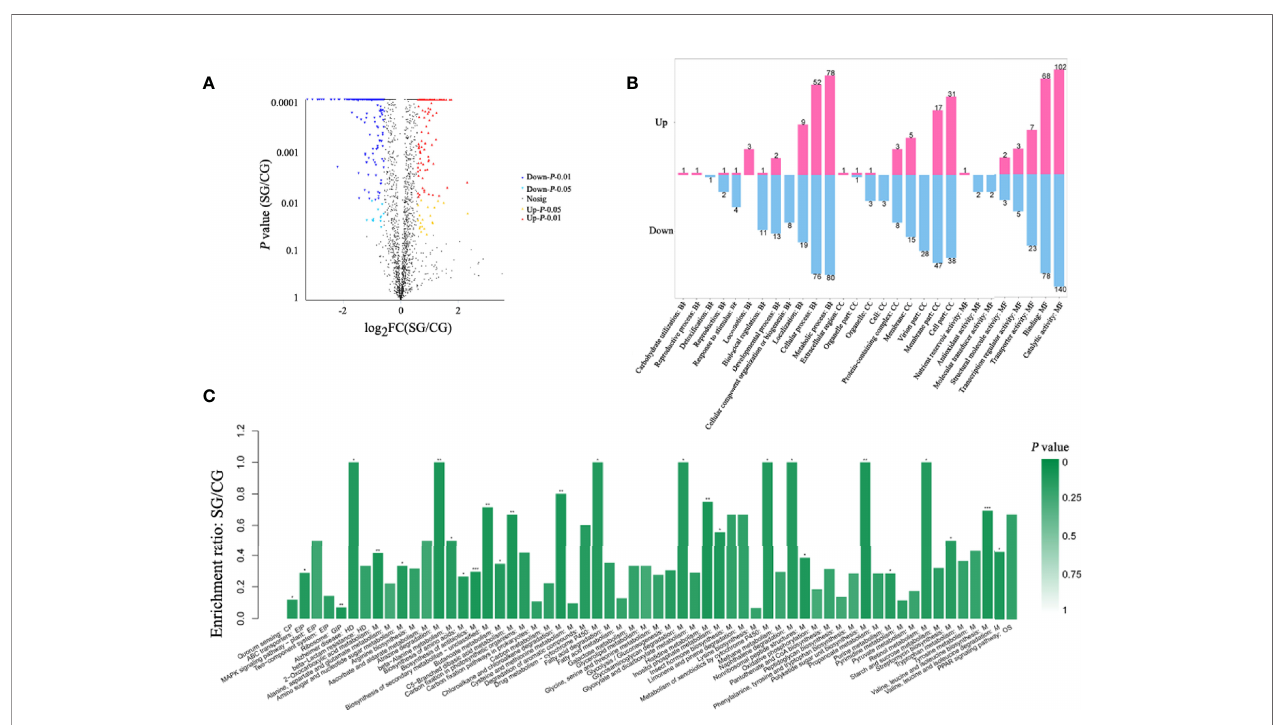
FIGURE 3 | Differential proteomic analysis which SG+BaX030 compared to CG+BaX030. (A) The volcano map of differential proteins; (B) GO analysis of the differential proteins; (C) KEGG analysis, biological pathways involved in differential proteins. *** P < 0.001; ** P < 0.01; * P < 0.05.